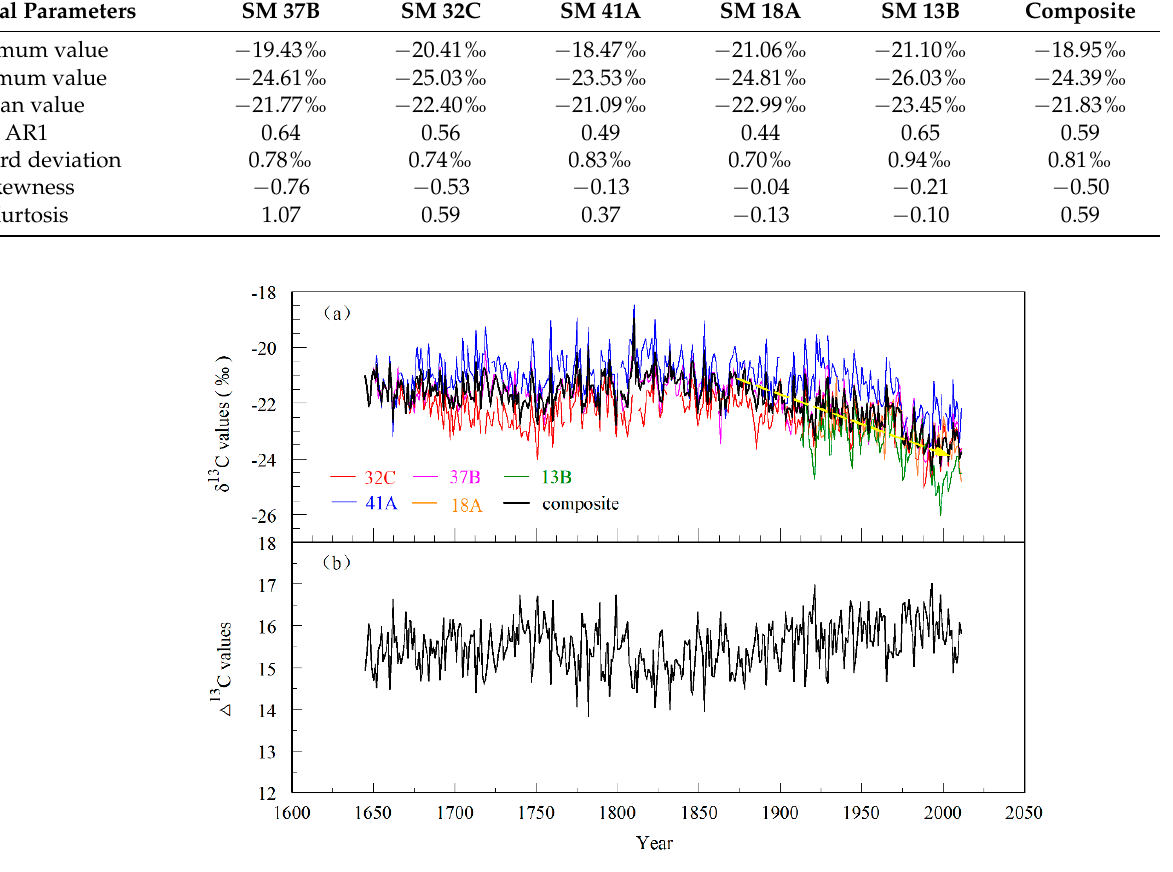
Figure 3. ( a ) Individual and composite tree ‐ ring cellulose δ 13 C time series of P. tabulaeformis (with 30 years of juvenile growth removed, the yellow, thick line is a downward trend), and ( b ) the composite tree ‐ ring cellulose Δ 13 C time series. Table 1. Statistical characteristics of individual and composite tree ‐ ring cellulose δ 13 C time series.